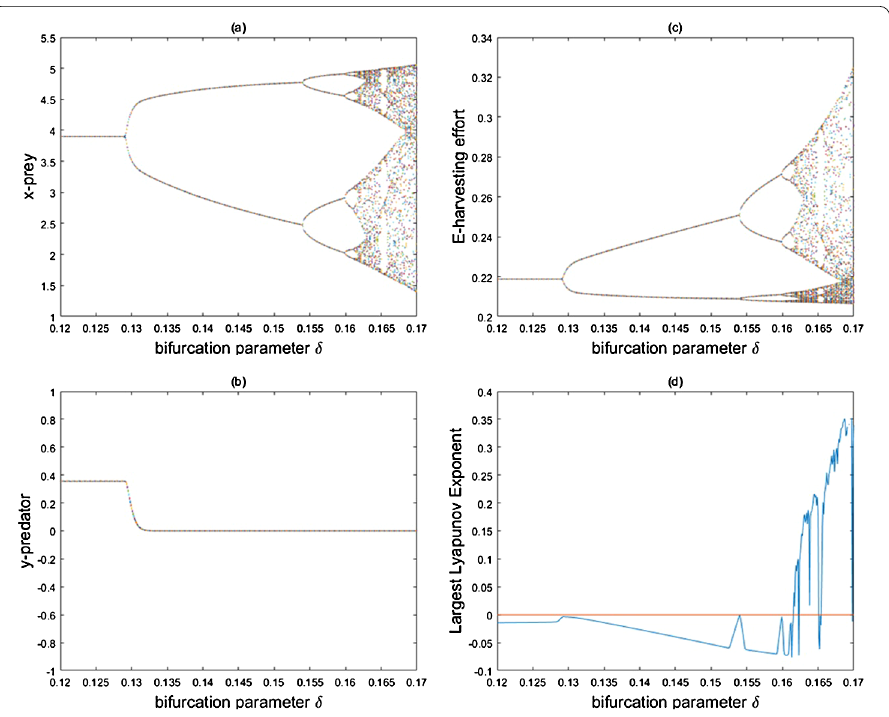
Figure 4 (a) Bifurcation diagram in ( δ , x ) plane. (b) Bifurcation diagram in ( δ , y ) plane. (c) Bifurcation diagram in ( δ , E ) plane. (d) Largest Lyapunov exponents corresponding to (a), (b), and